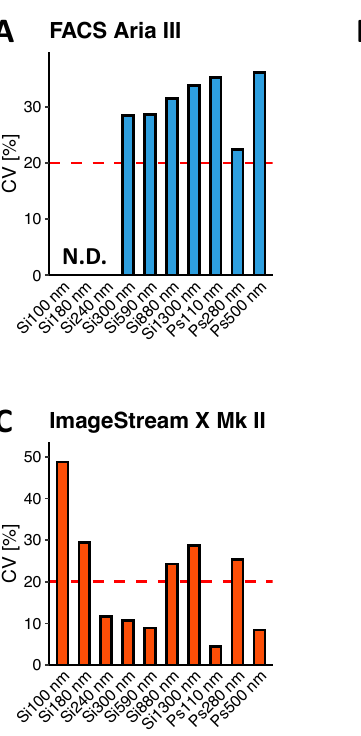
Figure 3. Variability in concentration determinations of synthetic nanospheres on ( A ) FACS Aria III, ( B ) Apogee A60 Micro-PLUS and ( C ) ImageStream X Mk II. The horizontal red, dashed line represents the arbitrary limit of quantification (LoQ) set in this study to a coefficient of variability (CV) of less than 20% for concentrations of synthetic nanospheres. CV: Coefficient of variability = standard deviation (SD)/mean for n = 5 per nanosphere population per platform; N.D.: Not